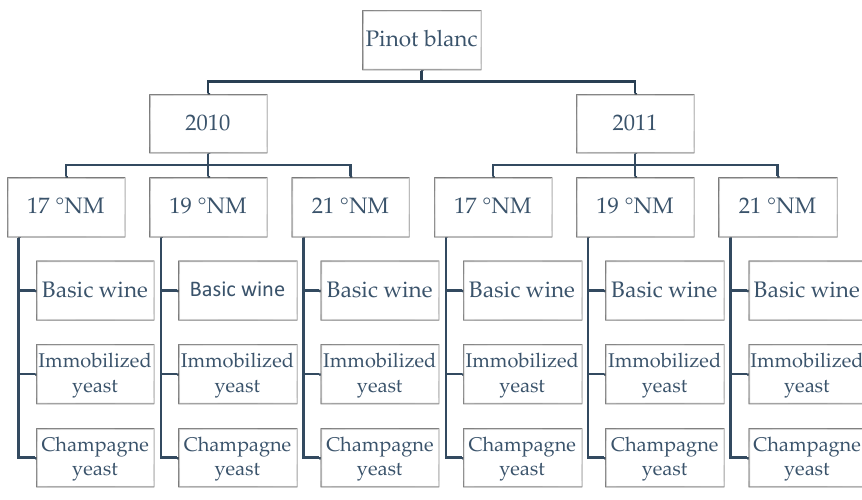
Figure 1. Experiment design.